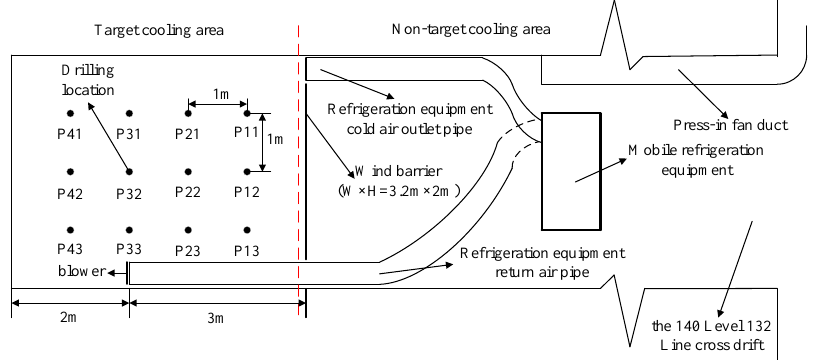
Figure 3. Layout of the test site.